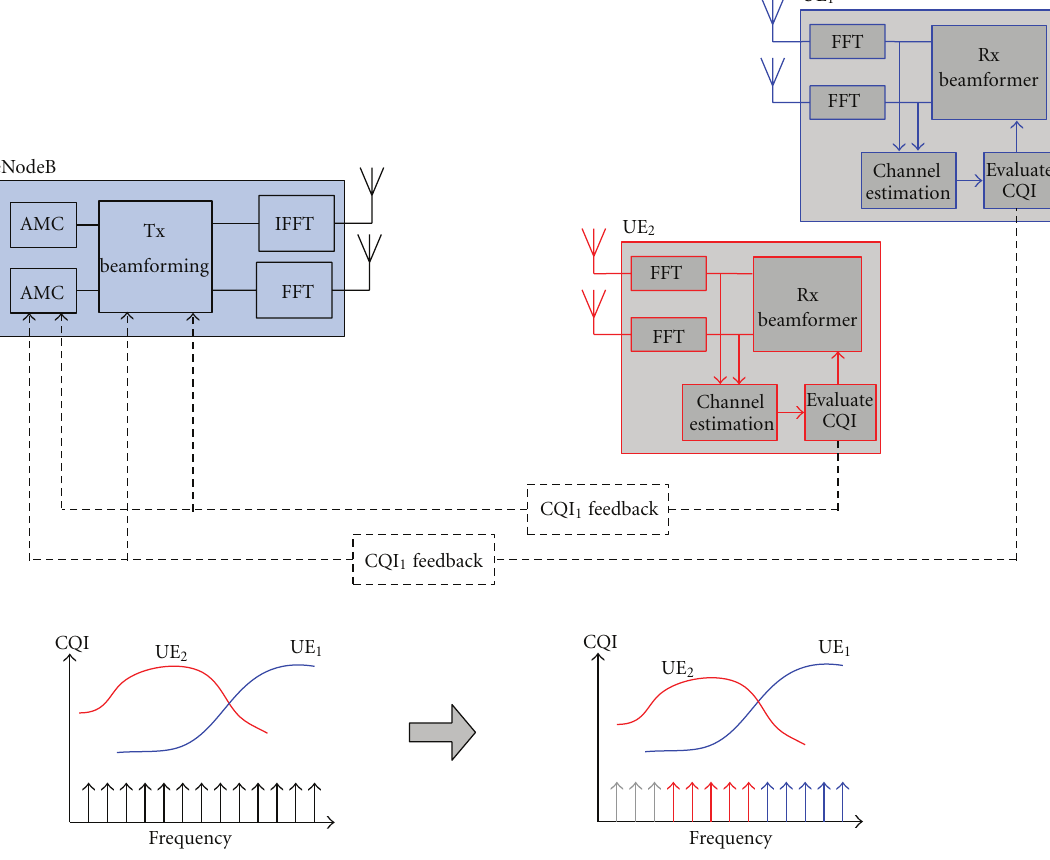
Figure 1: MU-MIMO with CQI feedback.